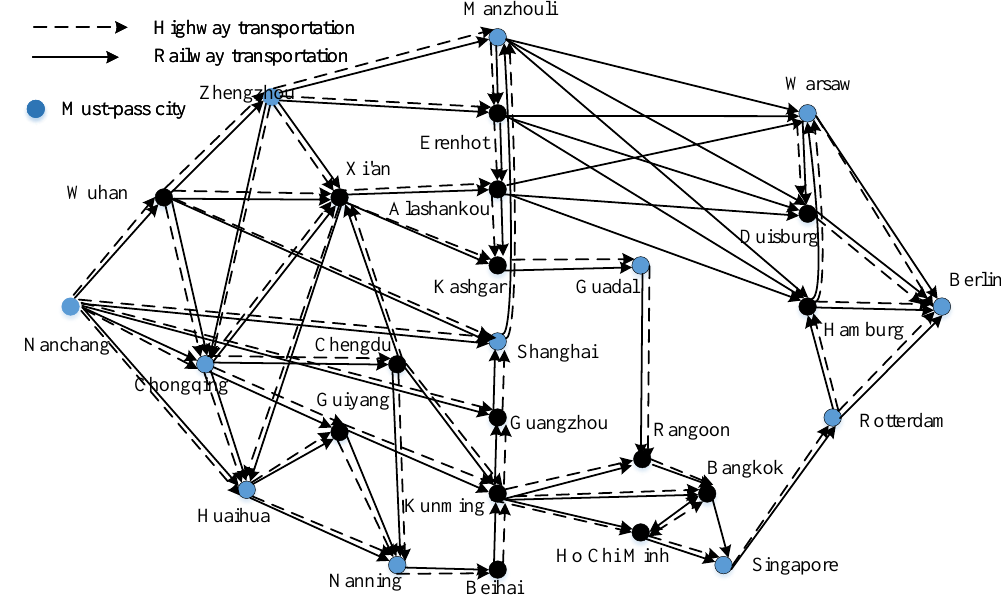
Figure 5. Multimodal transport network from Nanchang to Berlin.